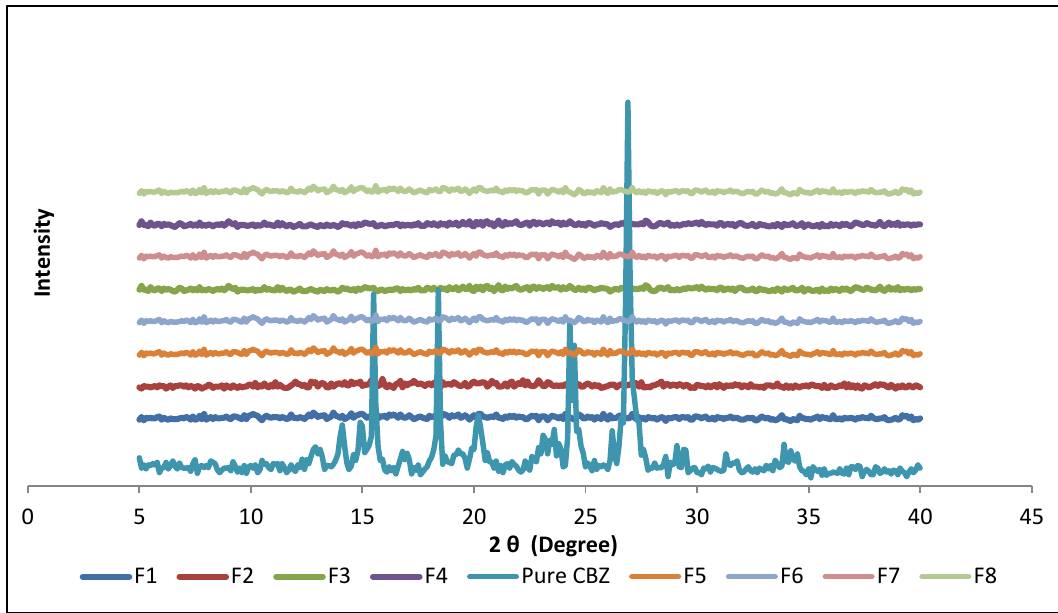
Figure 5. X-ray diffraction (XRD) data for pure CBZ and different formulations (F1 – F8) (15:85; CBZ: Soluplus ® ).